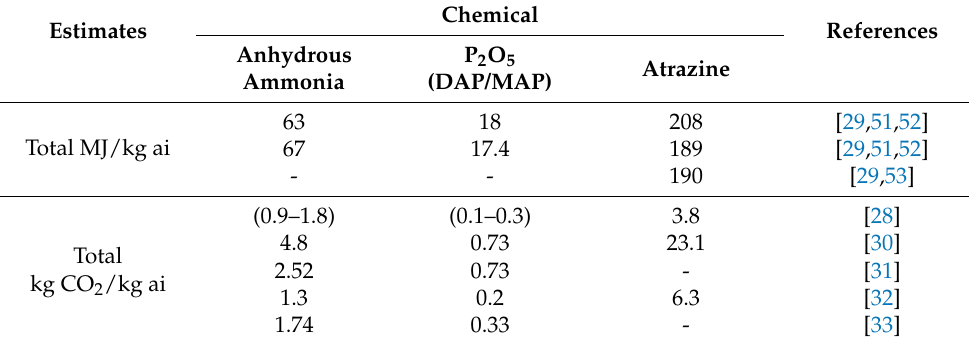
Table 4. Estimates of total energy (MJ/kg ai) and carbon equivalent (kg CO 2 /kg ai) for fertilizer and pesticide production, packaging, and transport for the Matson Ditch Watershed.